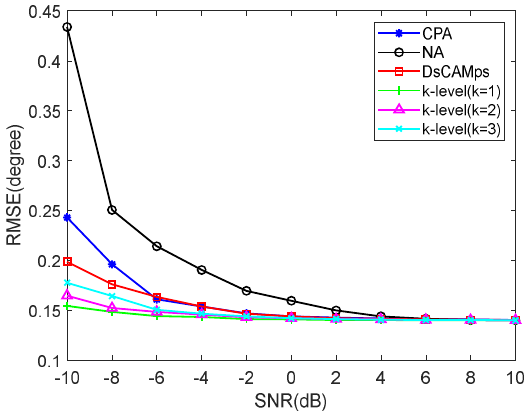
Figure 9. RMSE versus SNR with T p = T s = 600.